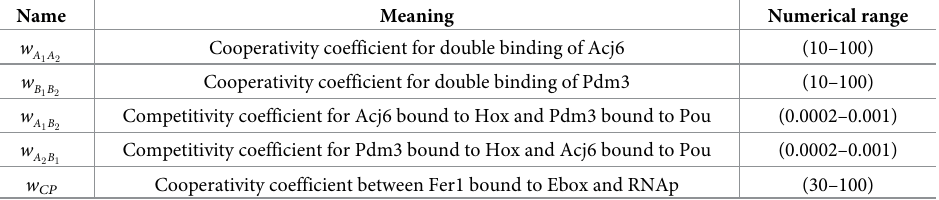
Table 3. Interaction parameters: Names, meaning and numerical ranges. Parameters describing TF-TF and TF-RNAp interactions in the model.